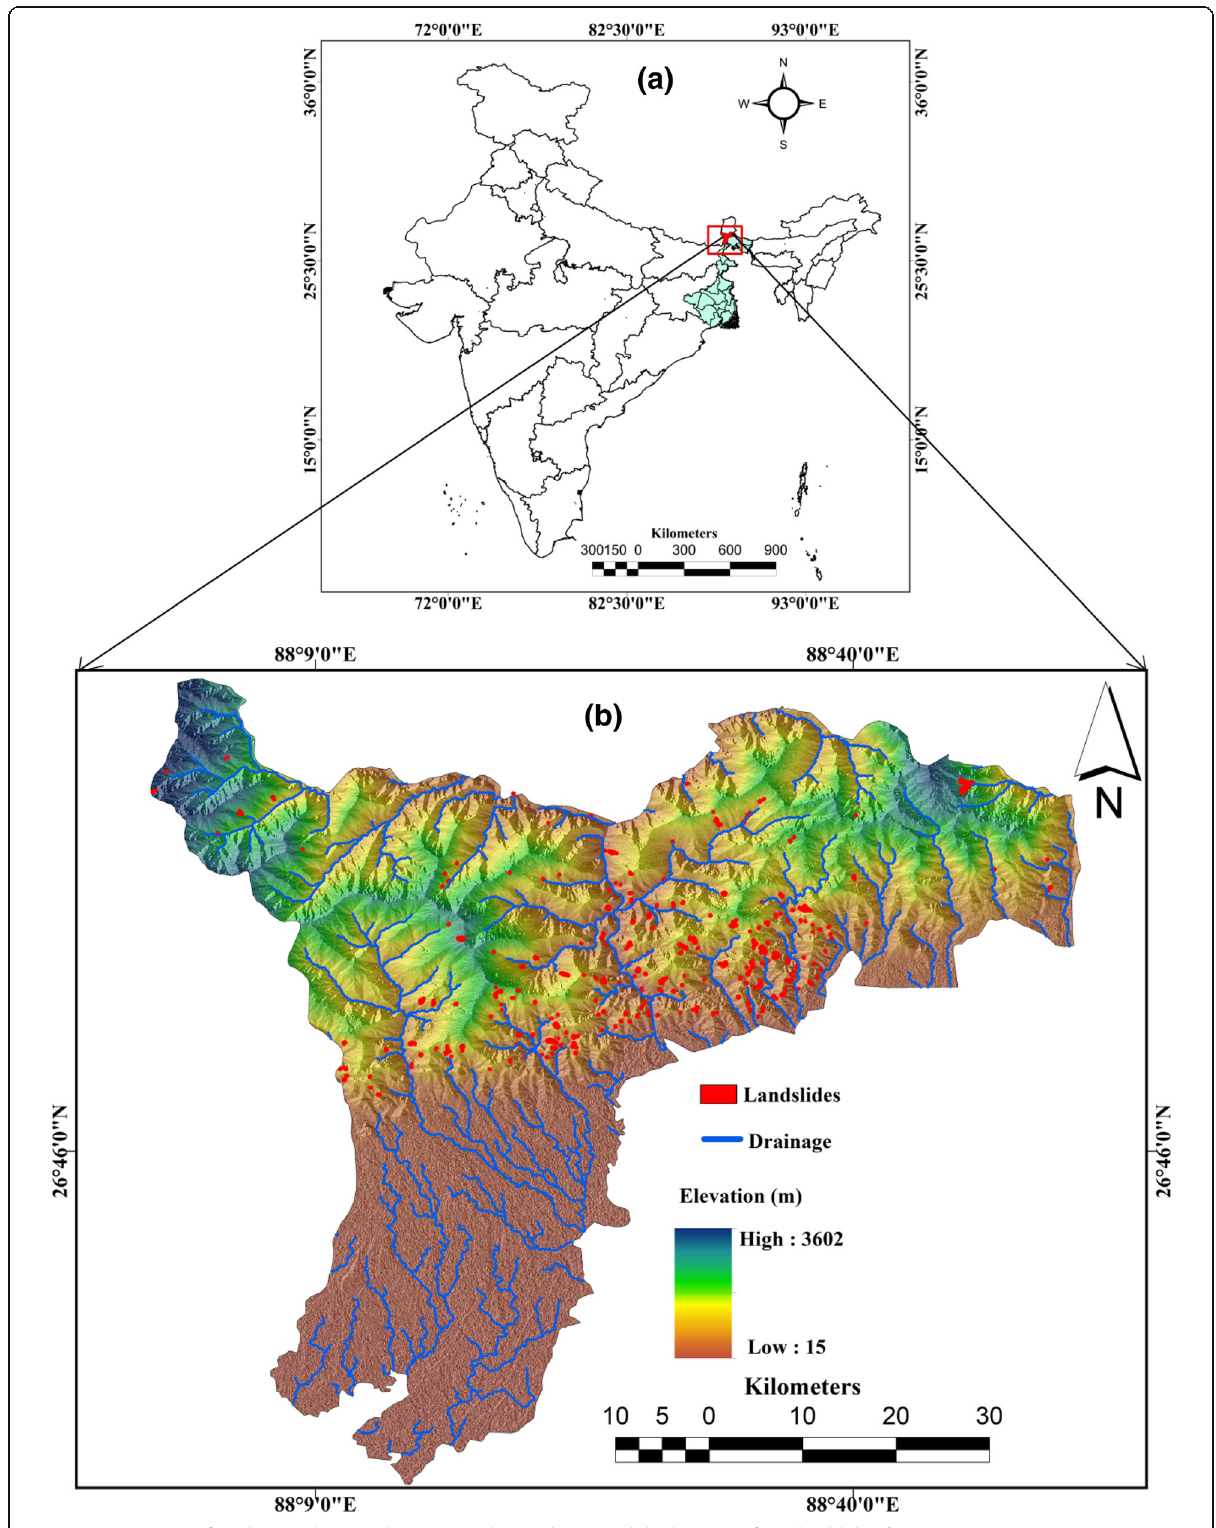
Fig. 1 Location map of study area showing district Darjeeling, India ( a ), and the location of 326 landslides ( b